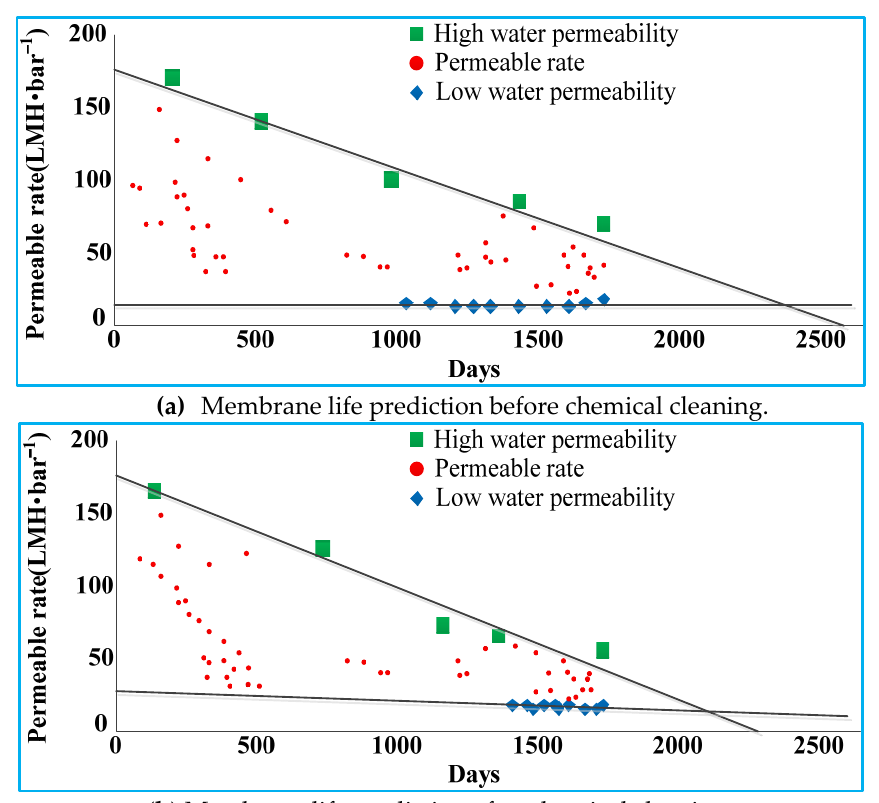
Figure 3. Membrane life